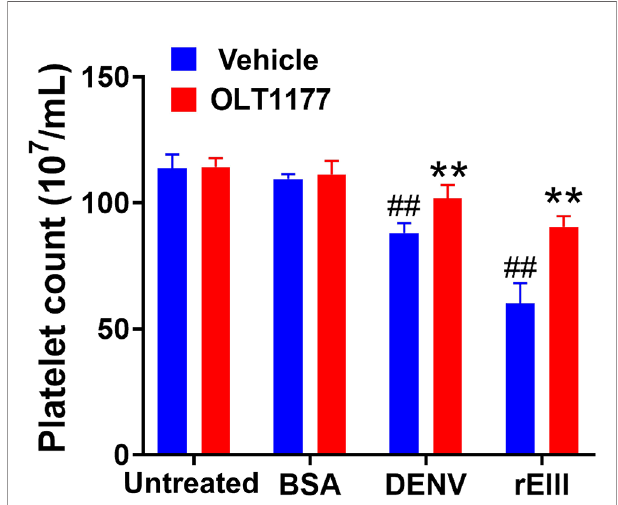
FIGURE 7 | Nlrp3 inhibitor treatments ameliorate DENV- and rEIII-induced thrombocytopenia in mice. Treatments with Nlrp3 inhibitor OLT1177 (50 mg/ kg) ameliorated DENV (3 × 10 5 PFU/mouse; DHF viral load)- and rEIII (2 mg/ kg)-induced thrombocytopenia in C57BL/6J mice. n = 6, ## P < 0.01 vs. untreated groups; ** P < 0.01 vs. respective vehicle